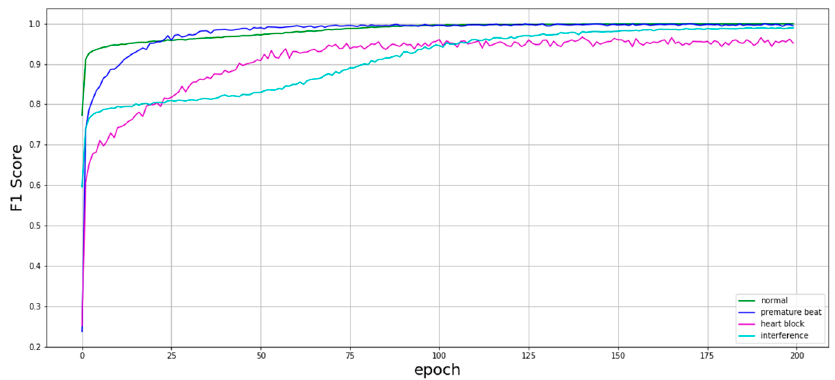
Figure 6. Training curve of the model.